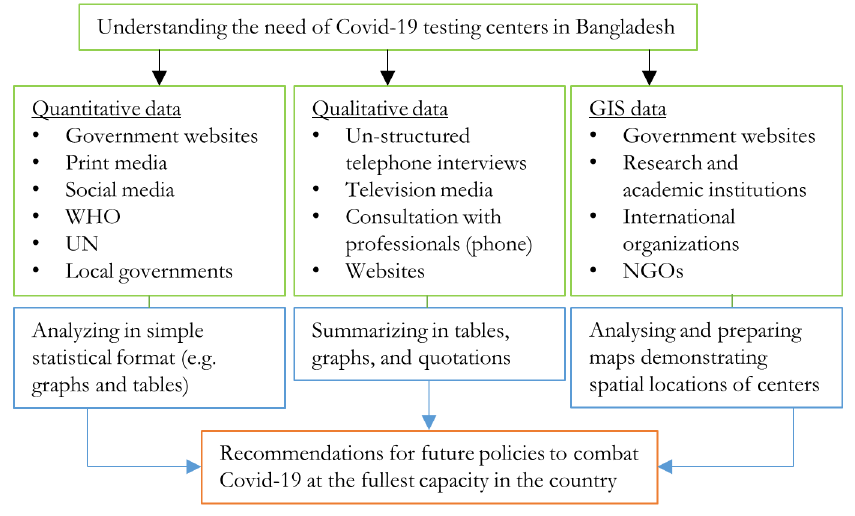
Figure 2. Schematic diagram of the study.